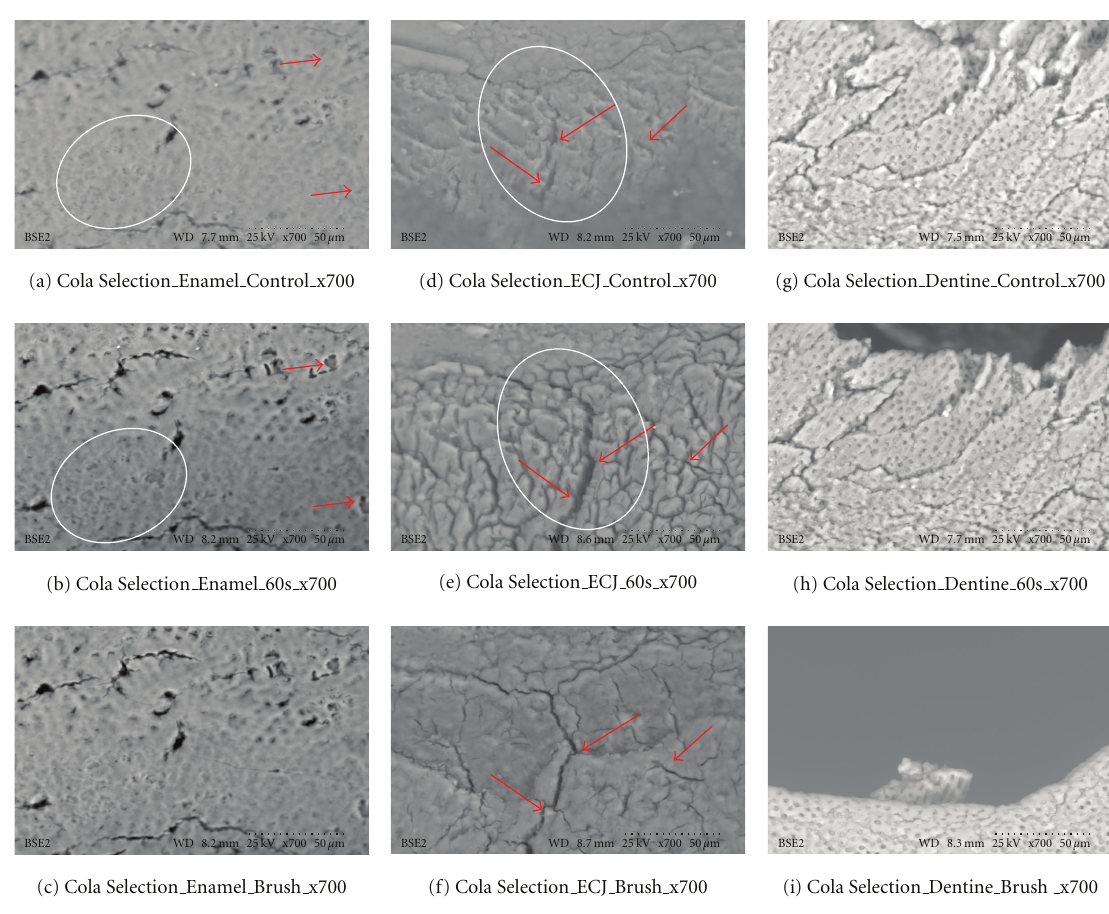
Figure 8: Coca Selection ( × 700). Outlined areas clearly show erosion with surface crenellations and profusion of shrinkage cracks from calcium loss when comparing (a), (d), and (g) to (b), (e), and (h). Minimal abrasion is present on the enamel, but red arrows from brush abrasion are clearly visible in (f); the surface cracks while enlarged from erosion appear narrower and less numerous, as the soft superficial material is lost to the action of the brush. These SEM results are also consistent with the calcium dissolution from swishes in Figure 3.